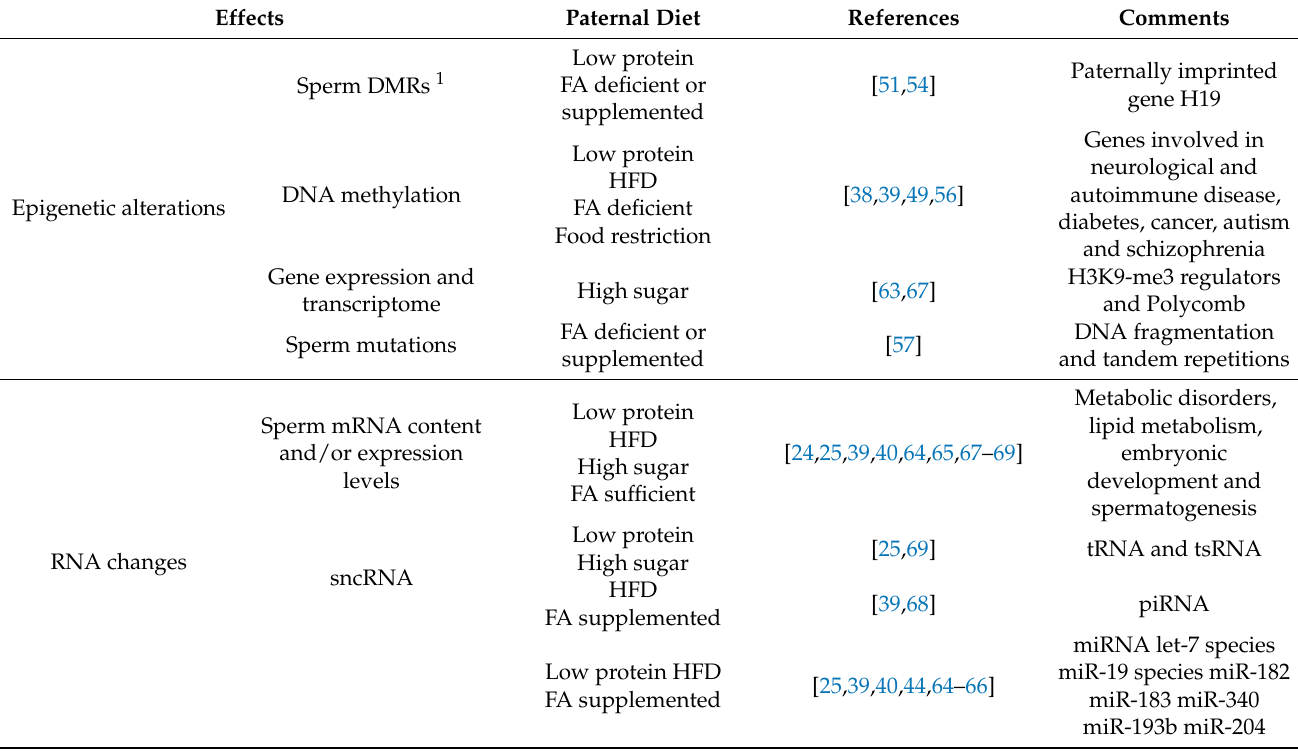
Table 2. Epigenetic and RNA alteration induced by fathers’ nutrition